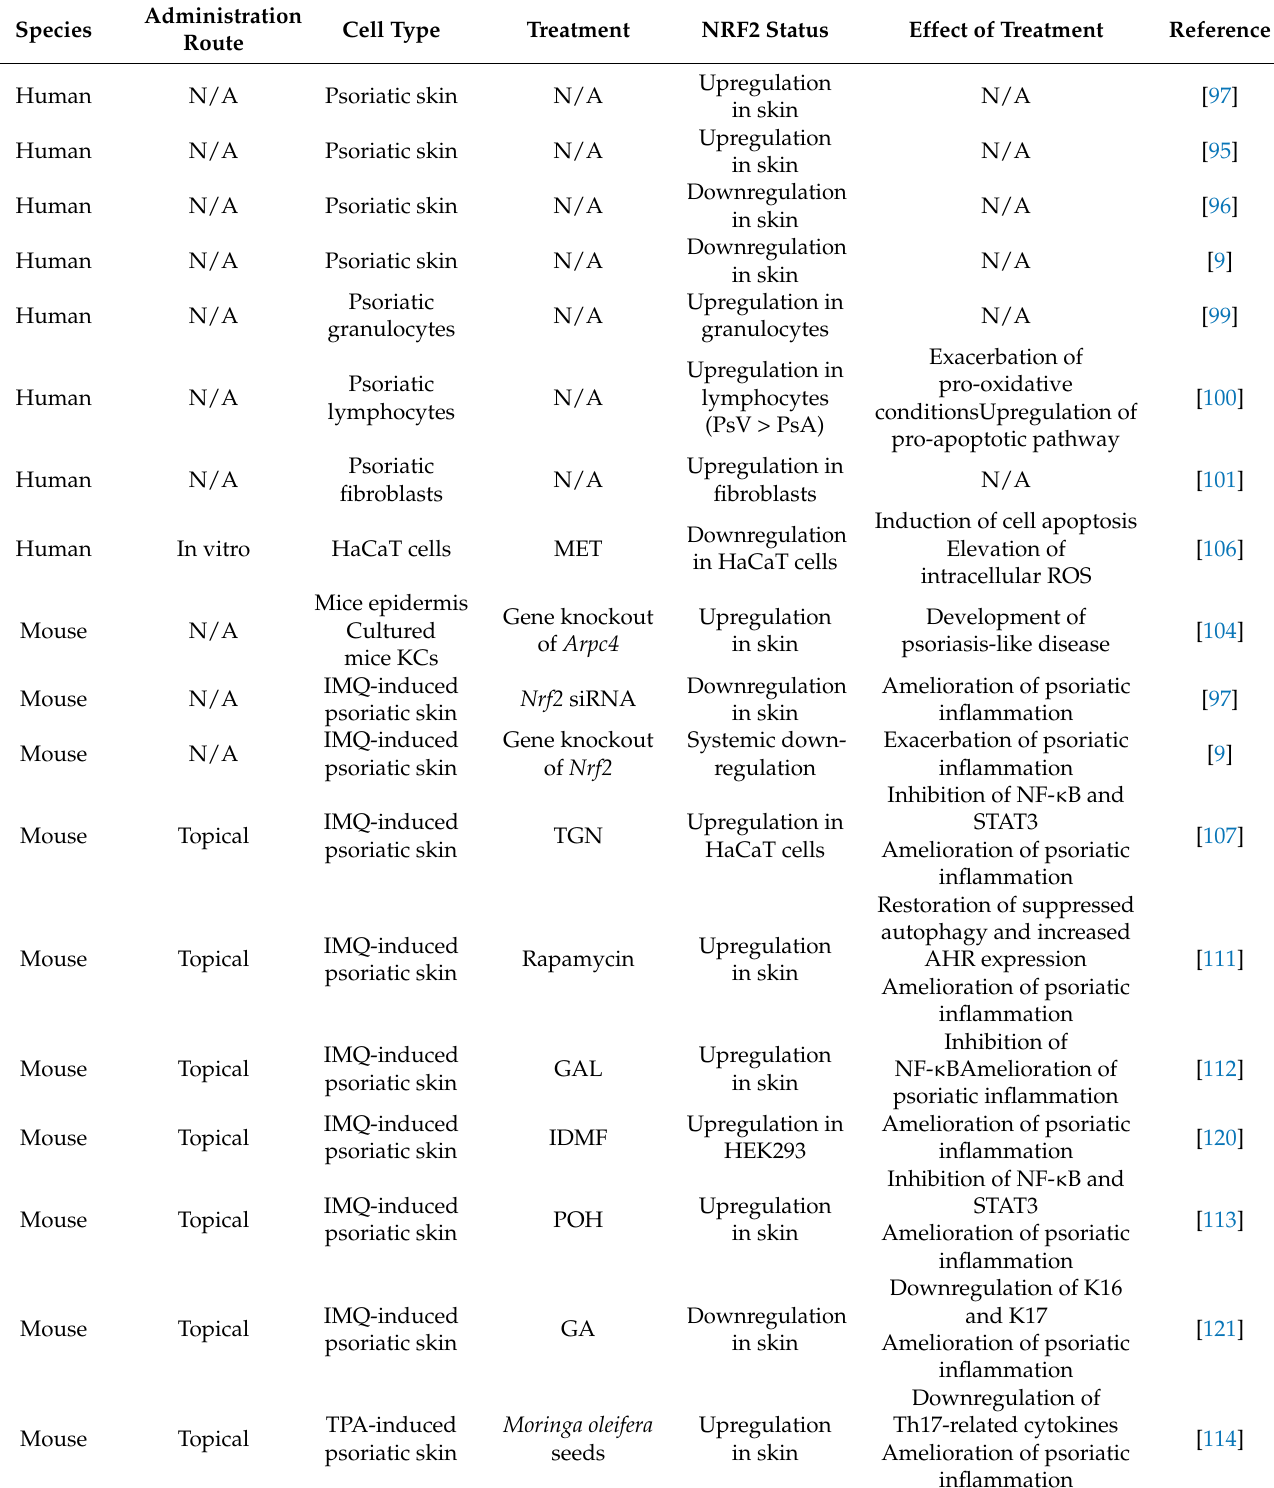
Table 2. NRF2 and